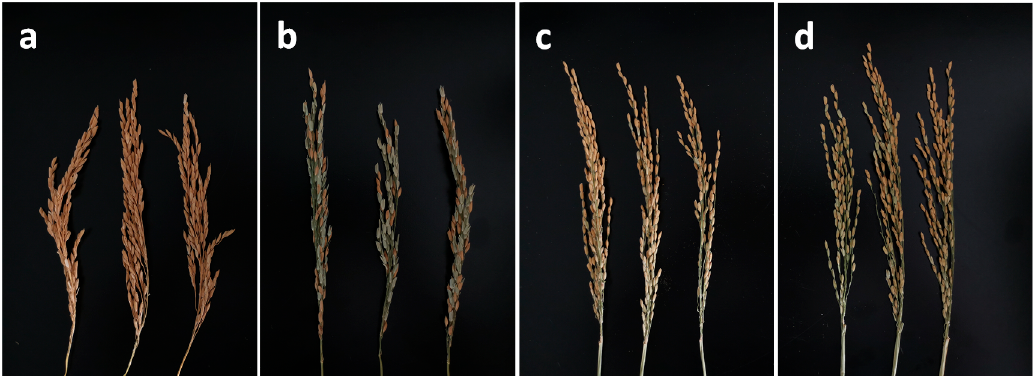
Figure 1. Mature spikes of 9311 and SDWG005 in the control (28 °C for 12 h per day) and heat treatment (38 °C for 12 h per day, for 5 days) conditions. ( a , b ) Panicles of 9311 plants under normal and heat stress conditions, ( c , d ) Panicles of SDWG005 plants under control and heat stress conditions.